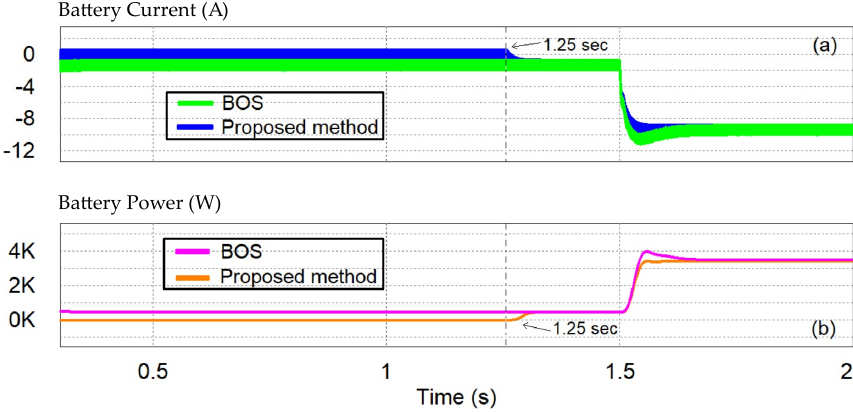
Figure 20. ( a ) The battery current; ( b ) the battery power—Case 3.